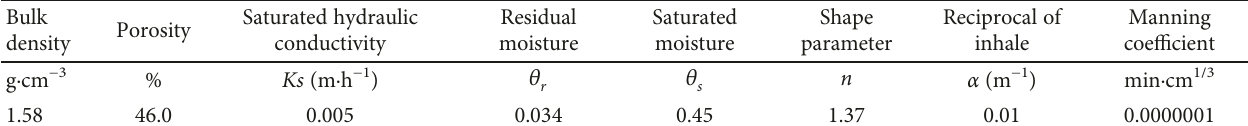
Table 4: Hydrodynamic parameters of the soil matrix and surface runo ff parameters.